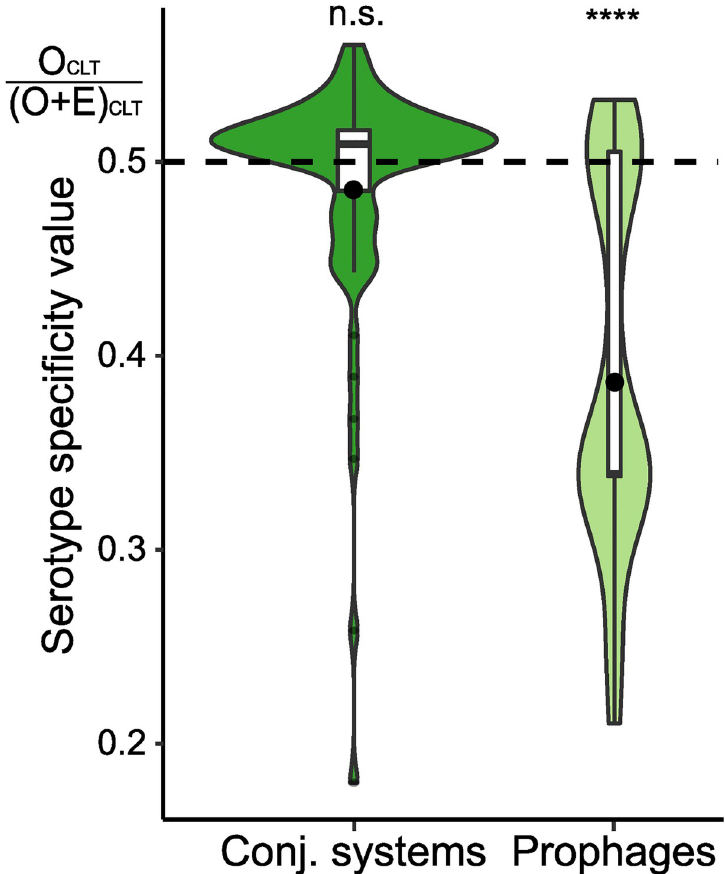
Fig 5. Serotype specificity of prophages and conjugative systems. O CLT : observed number of serotypes infected per family of homologous element. E CLT : expected number of serotypes infected per family of homologous element generated by 1,000 simulations (see “CLT specificity”). This measure aims to capture the number of different CLT that each prophage and conjugative system were able to infect, compared to what was expected by chance given the phylogeny. When the elements distribute randomly across CLTs, the value is 0.5 (dashed line). Very low values indicate high serotype specificity. One-sample Wilcoxon test. ���� : p -value < 0.0001 (https://doi.org/10.6084/m9. figshare.14673162). CLT, capsular locus